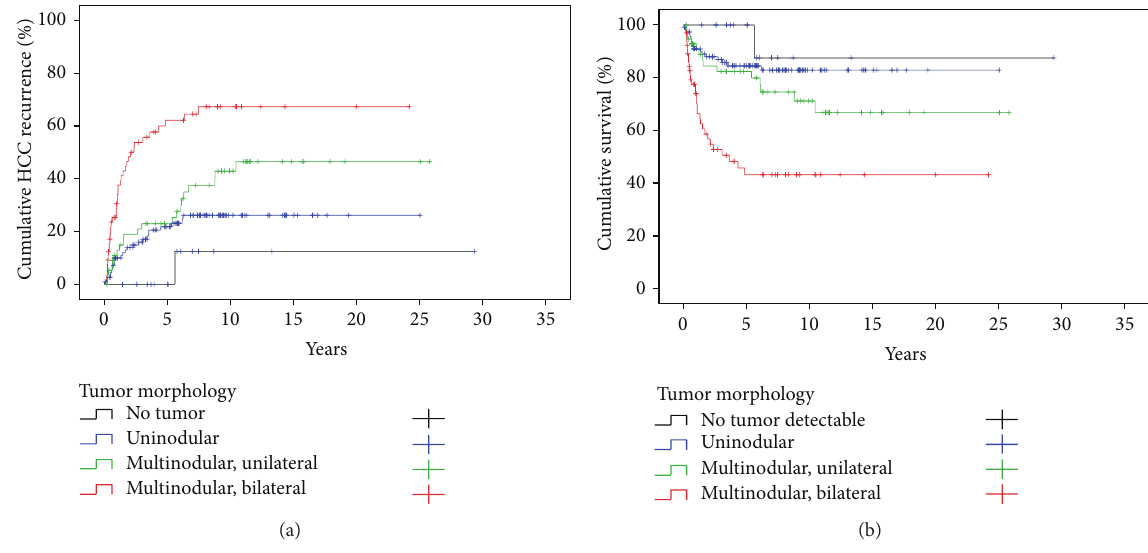
Figure 5: HCC recurrence (a) and survival (b) with respect to tumor morphology. HCC recurrence (hospital deaths excluded) (a) was significantly influenced by tumor morphology (Log Rank 𝑝 < 0.001 ). Survival (hospital deaths and non-HCC recurrence related deaths excluded) (b) was significantly influenced by the intrahepatic tumor dissemination of the primary HCC (Log Rank 𝑝 < 0.001